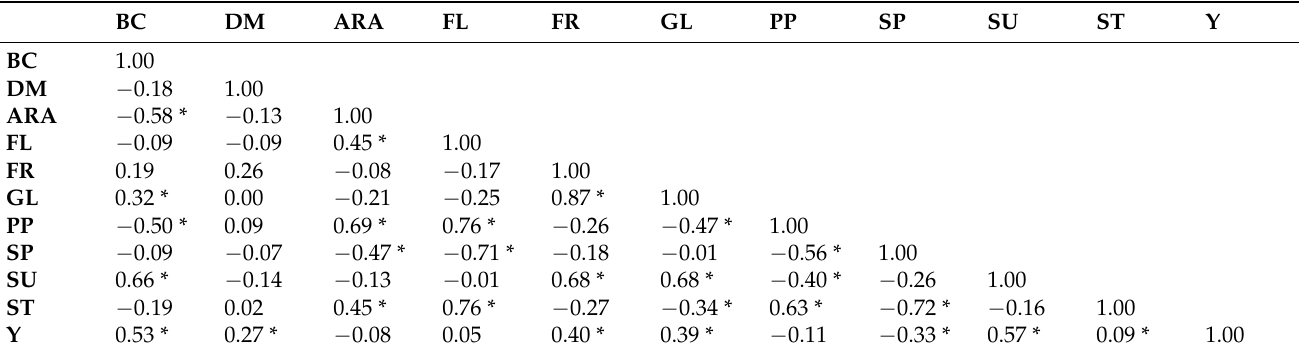
Table 6. Pearson’s correlation coefficient among nutraceutical traits and storage root yield.